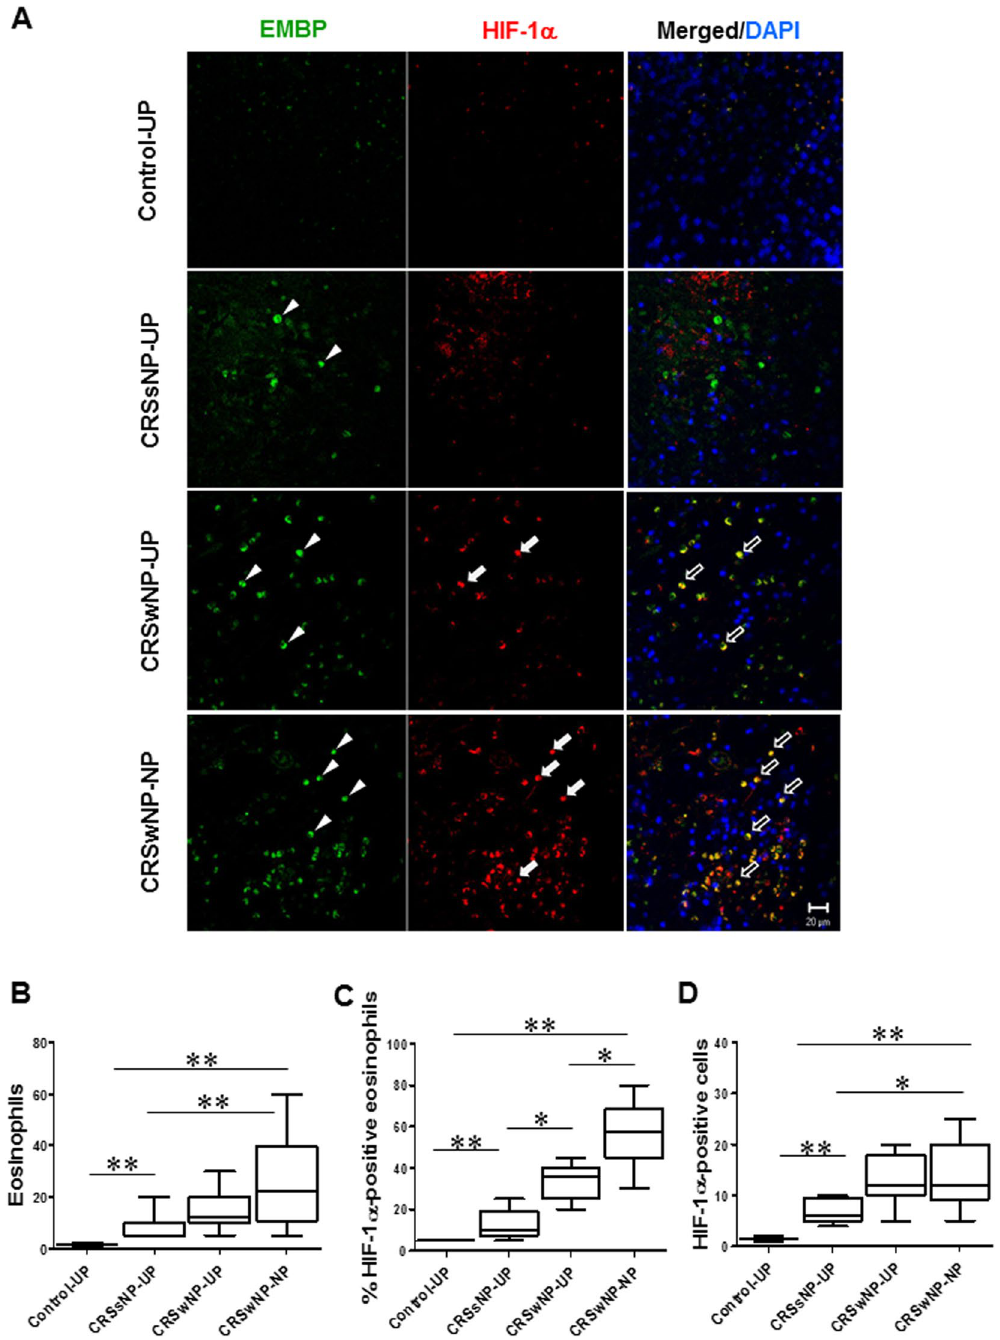
Figure 1. Fluorescence micrographs of HIF-1 α expression and distribution of EMBP in nasal mucosal tissue. ( A ) Confocal images show colocalization of HIF-1 α and EMBP (black arrows) in nasal mucosal tissue from control subjects and patients with CRSsNP, a patient with CRSwNP, and a NP sample. White arrowheads indicate EMBP-positive and arrows show HIF-1 α -positive cells. Cell nuclei were counterstained by DAPI (4 ′ ,6-diamidino-2-phenylindole). ( B – D ) Distribution of eosinophils and percentage of HIF-1 α -positive cells in nasal mucosal tissue. The number of HIF-1 α - positive cells was considerably higher in the NP tissues of the CRSwNP group compared to the other groups. Data are expressed as the means ± SD. * P < 0.05, ** P < 0.01. Mann-Whitney U test. Scale bar = 20 μ